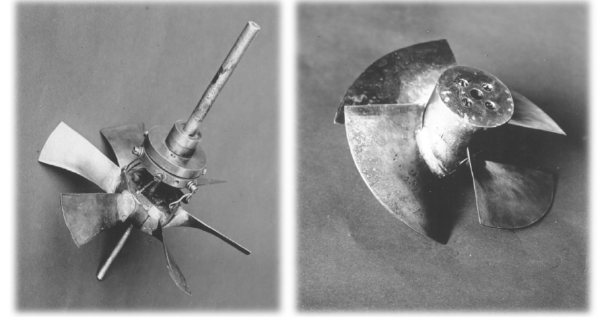
Figure 8. Impellers with rotatable blades. Source: